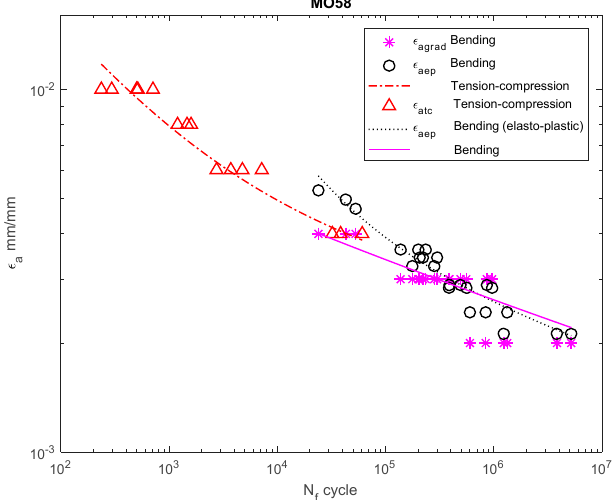
Figure 9. Dependency chart for the strain amplitude ε a = f ( N f ) for 16Mo3 steel.